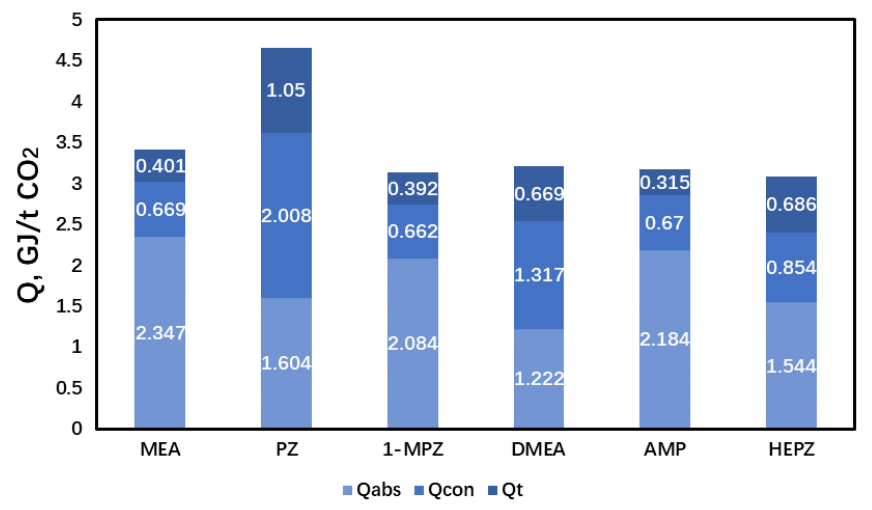
Figure 9. The proportion of different heat in the reboiler energy of different solvents.